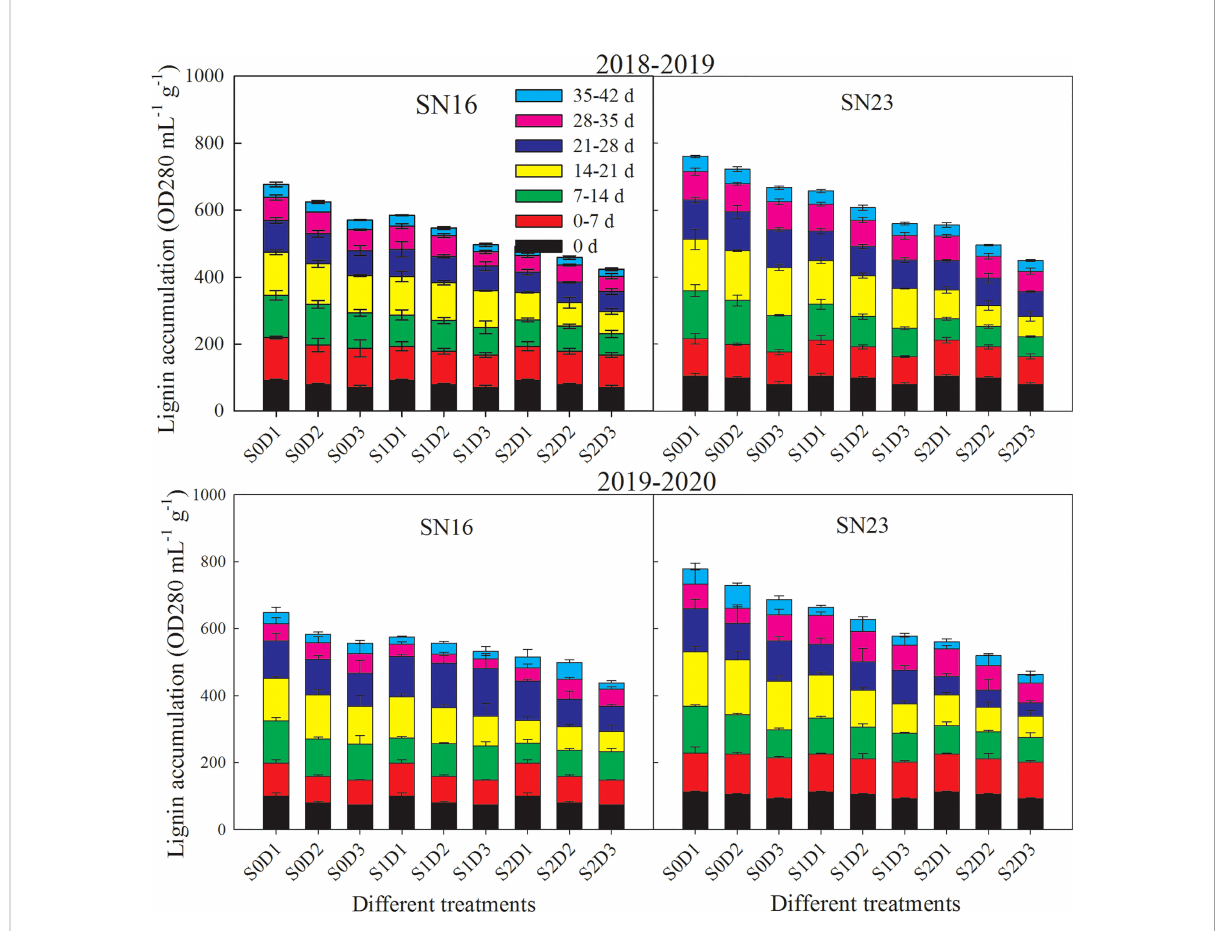
FIGURE 4 Effects of shading on the content of lignin in wheat stems under different planting densities. Error bars represent the standard deviation of the mean (n =